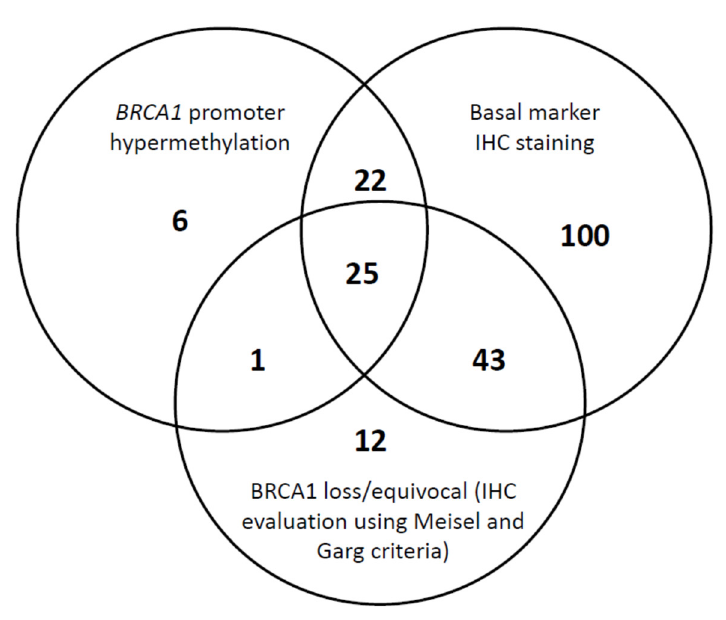
Figure 3. Shared BRCA1 (Breast Cancer 1) deficiency measures in triple negative breast cancers.